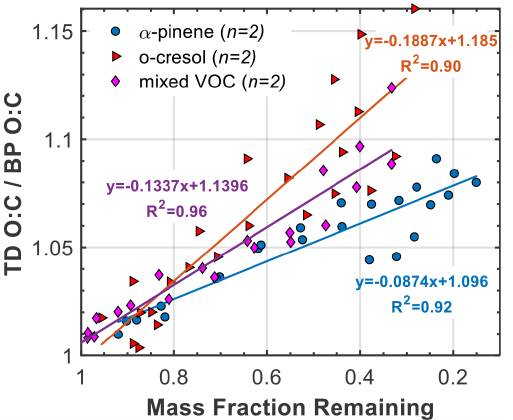
Figure 4. SOA particle volatility distributions retrieved from the TD measurements for three characteristic experiments (experiment nos. 2, 6, and 10; Table 1). The error bars represent the uncertainty in the estimated values in each volatility bin.